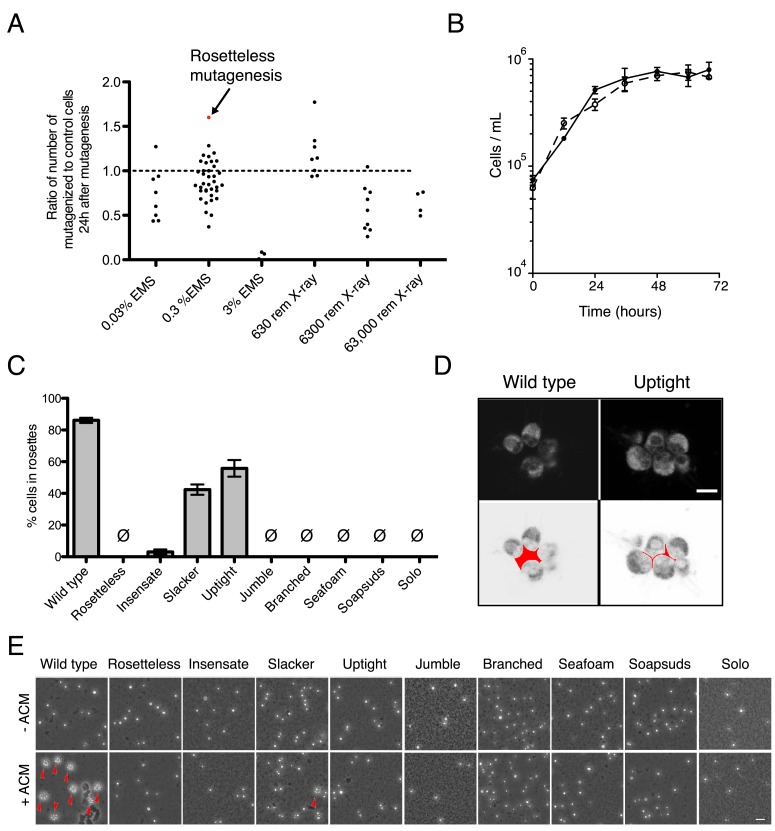
Mutagenesis and mutant phenotypes.(A) Vertical scatter plot showing the effect of mutagenesis on cell number, shown as the number of mutagenized cells divided by the number of cells in a paired, unmutagenized culture at 24 hr post-mutagenesis. Each dot represents one mutagenesis experiment and the mutagenesis from which the Rosetteless mutant was isolated is highlighted (red). The dotted line at 1.0 represents no effect. The mutagen doses used in the screen were 0.3% EMS (vol/vol) and 6300 rem X-rays, which each resulted, on an average, in a decrease in cell number (p < 0.05, Wilcoxon signed rank test). (B) Growth curve of wild-type (open circles, dotted line) and Rosetteless mutant (filled circles, solid line) cells shows that the Rosetteless phenotype is not due to a growth defect. Error bars show standard deviation. (C) Quantification of rosette induction in the presence of live A. machipongonensis, shown as mean ± SEM. Ø represents cultures in which no rosettes were observed (limit of detection = 0.03%). Compare to Figure 3B to see rosette induction from A. machipongonensis conditioned media (ACM) rather than live bacteria. Notably, the insensate mutant shows a low level of rosette induction when exposed to live bacteria but not when exposed to ACM. (D) Single confocal slices through rosettes stained with FM 1–43X dye showed differences in cell packing within wild-type and uptight mutant rosettes. Bottom: inverted images were false colored to mark the space between cells in the center of the rosette. Scale bar = 5 µm. (E) Phenotypes of rosette defect mutants after vigorous pipetting. Rosettes (red arrowheads) form in the presence of ACM and are robust to pipetting, whereas chain colonies break up into single cells. The uptight mutant occasionally formed rosettes, but none were visible in this field of view. Scale bar = 20 µm.